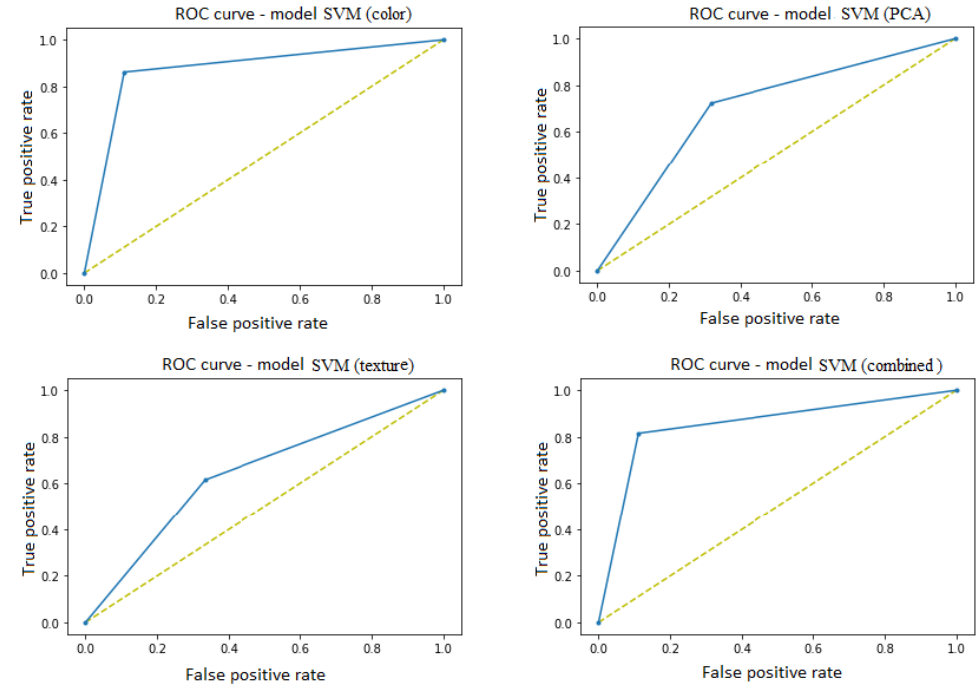
Figure 14. ROC curves of the Support Vector Machine (SVM)